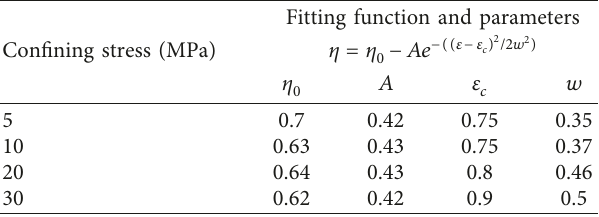
Table 2: Fitting function and parameters of DE